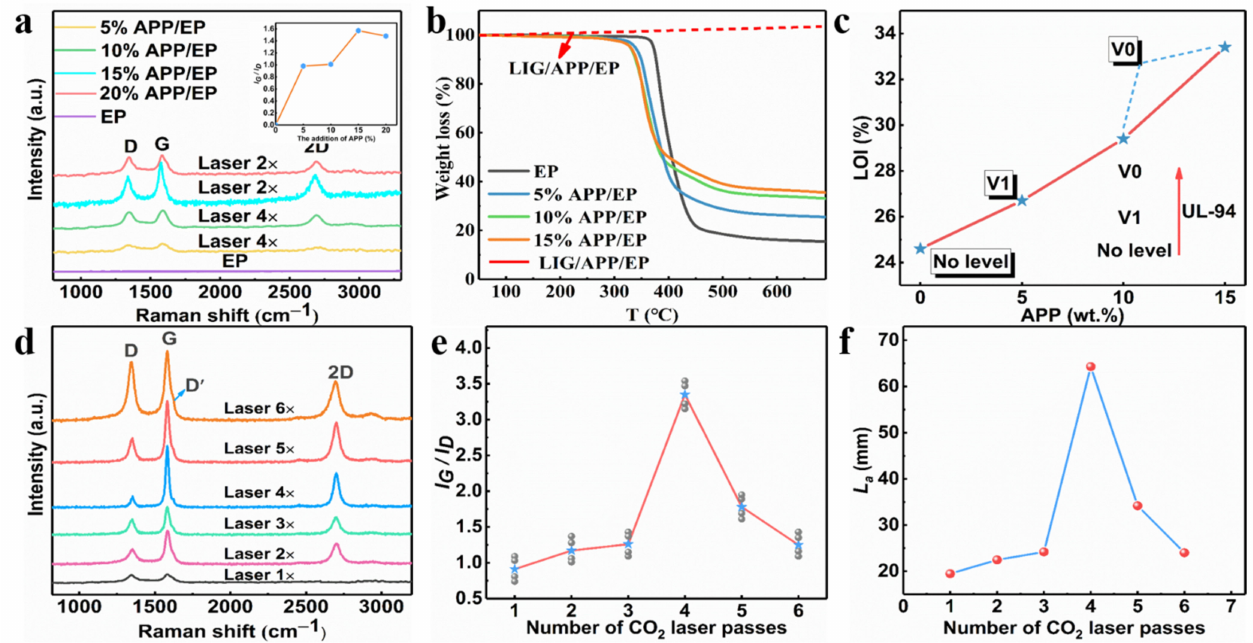
Figure 2. ( a ) TGA curves for the APP/EP composites with different APP content and LIG/APP/EP in an air atmosphere. ( b ) The limiting oxygen index (LOI) value (%) and the UL-94 rating for the EP and APP/EP composites with different APP contents. ( c ) Raman spectrum curves of the LIG formed on APP/EP with different APP contents and the numbers of laser passes, and the inset is the corresponding I G / I D ratio. ( d ) Raman spectra of the LIG generated with different numbers of laser passes. ( e ) The integrated intensities of the G and D peaks ( I G / I D ) for different LIGs. ( f ) The crystalline size ( L a ) along the a -axis of different